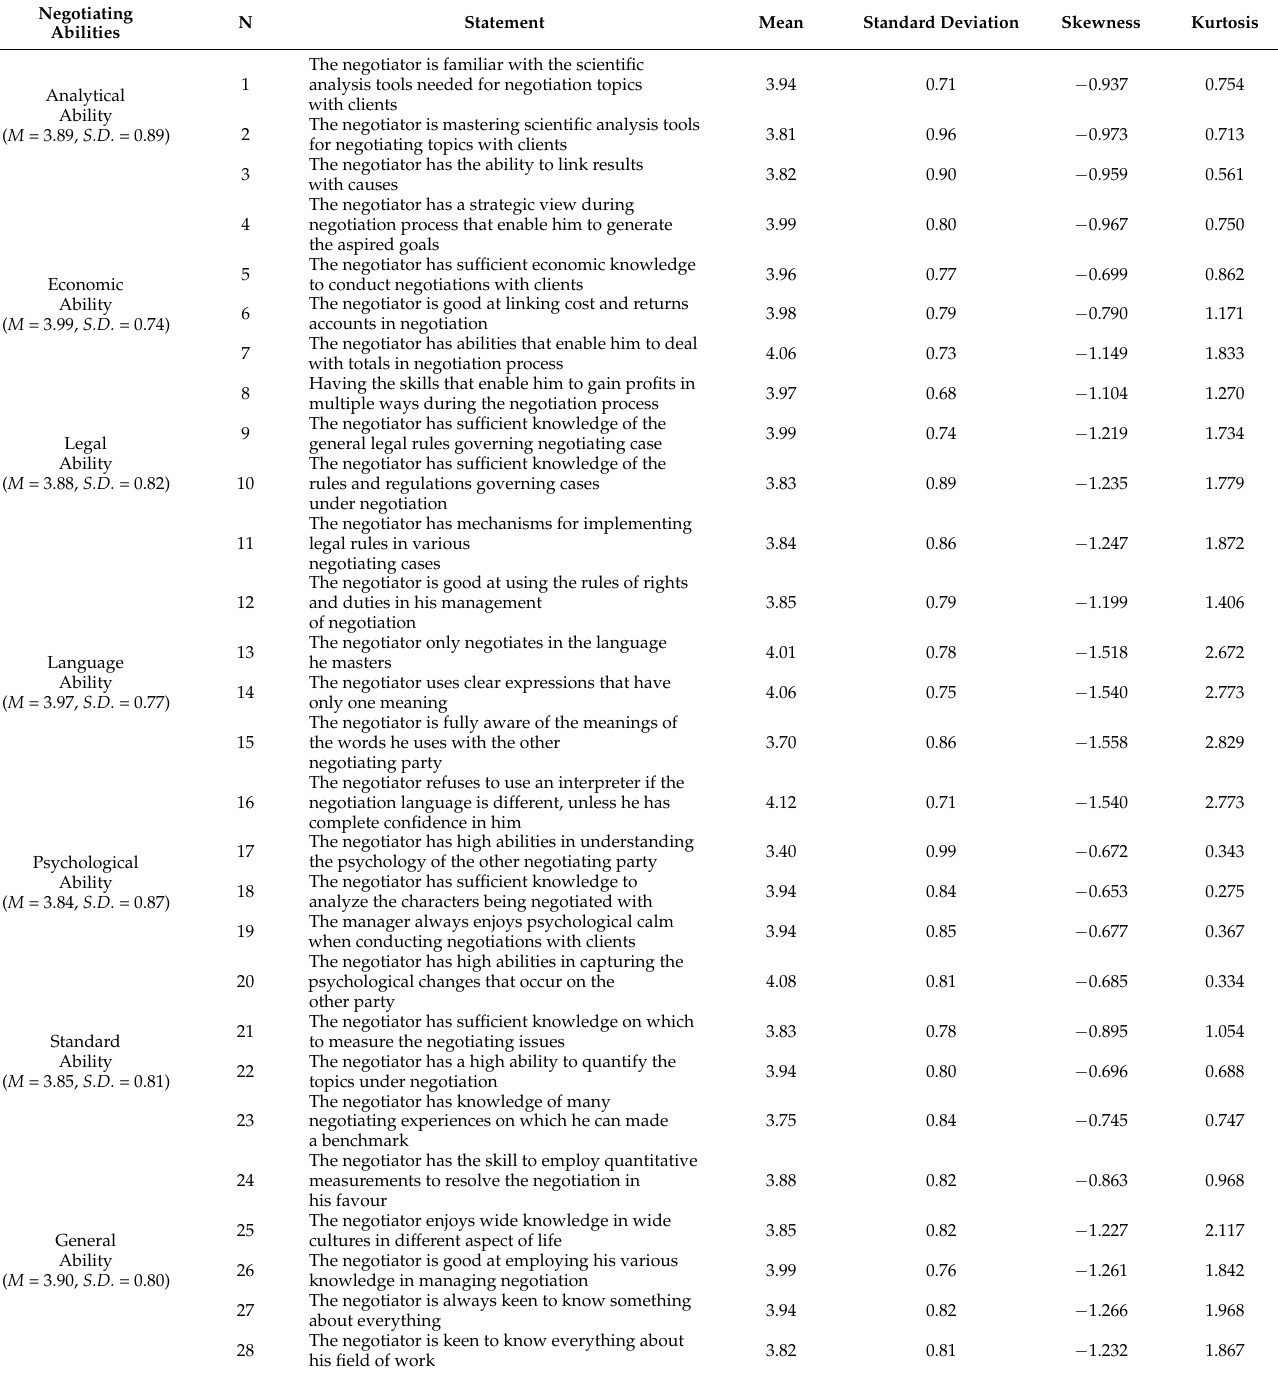
Table 4. The arithmetic means and standard deviations of the objective abilities of the